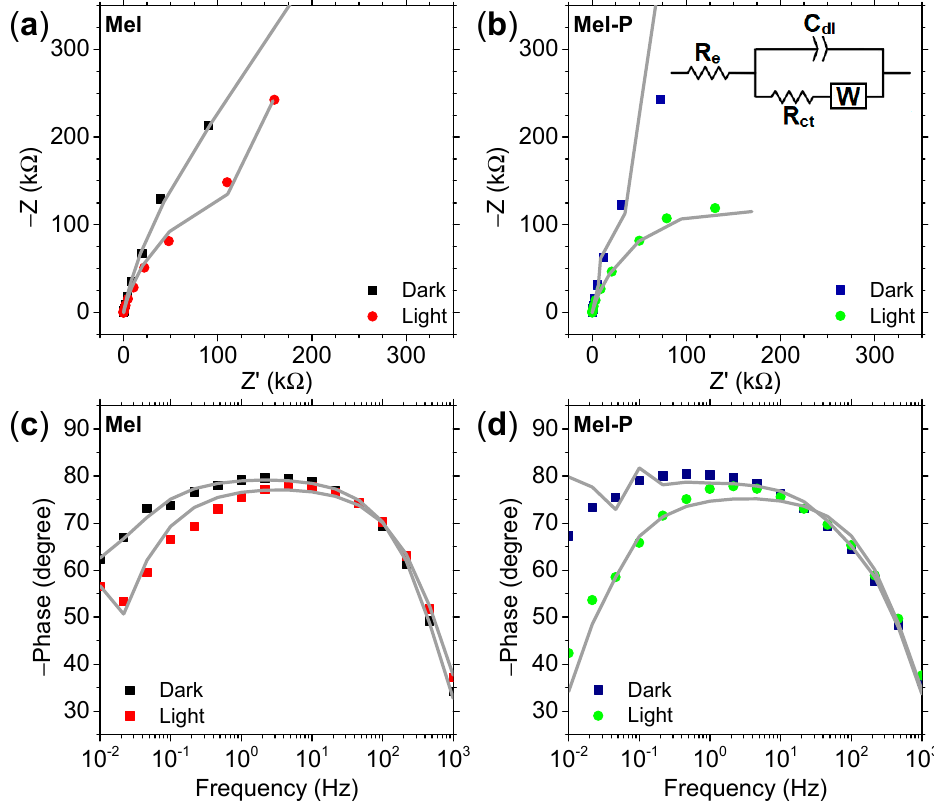
Figure 5. ( a , b ) Nyquist plot and ( c , d ) phase angle as a function of frequency in the dark and under illumination. The inset in ( b ) corresponds to the equivalent circuit used for spectra fitting.